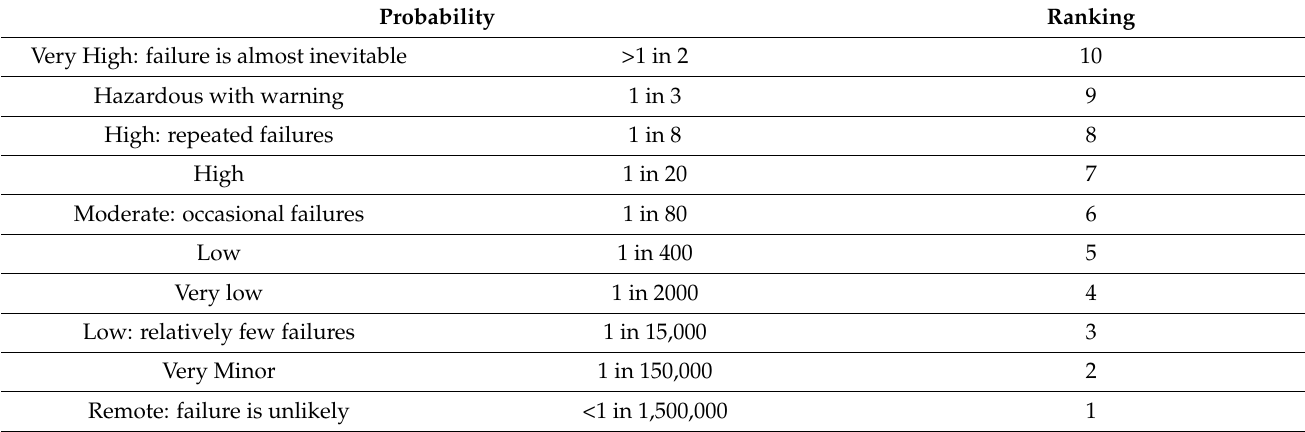
Table A4. Probability criteria.